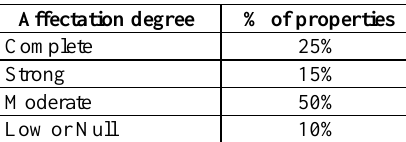
Table 1. Property Affectation